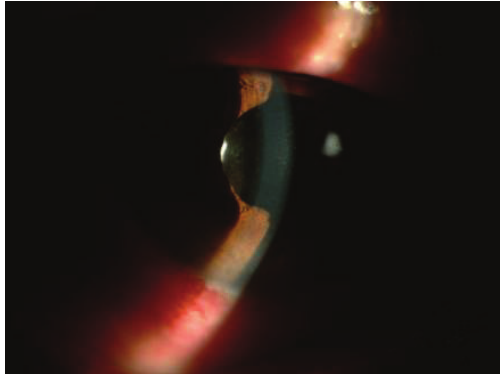
Figure 2: Preoperative slit-lamp photograph of the right eye in Case 1. A shallow anterior chamber was present.